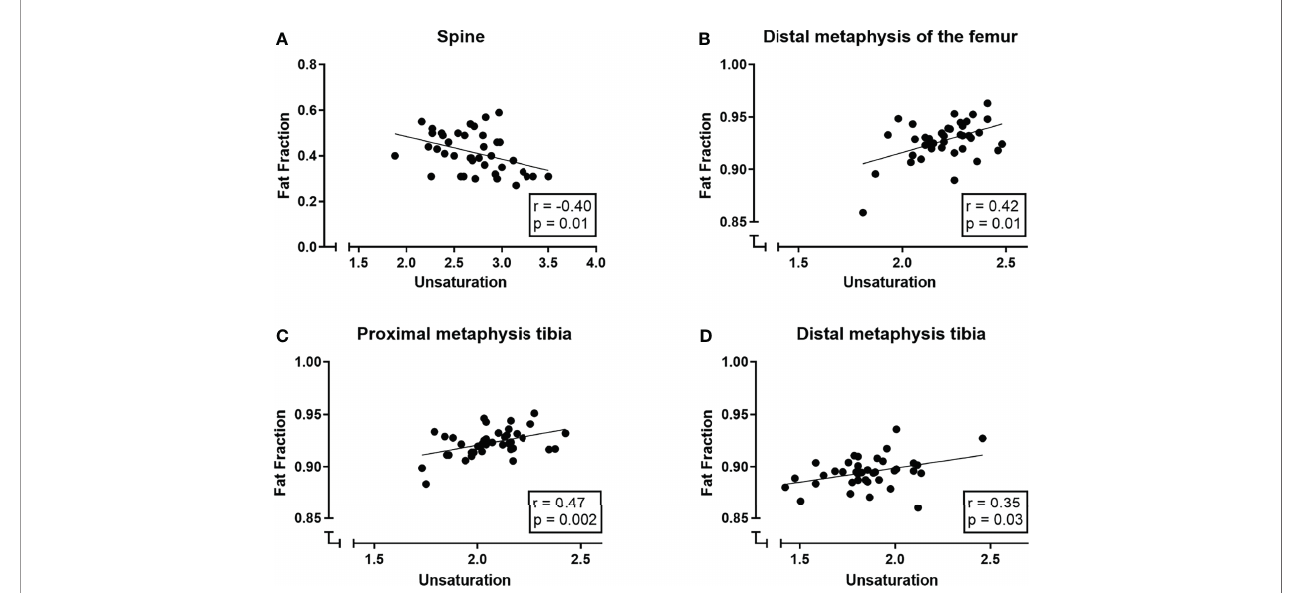
FIGURE 5 | Correlations (Pearson correlation coef fi cient) between bone marrow signal fat fractions ( S FF ) and unsaturation (number of double bonds ndb ) in (A) the spine, (B) the distal femur, (C) the proximal tibia and (D) the distal